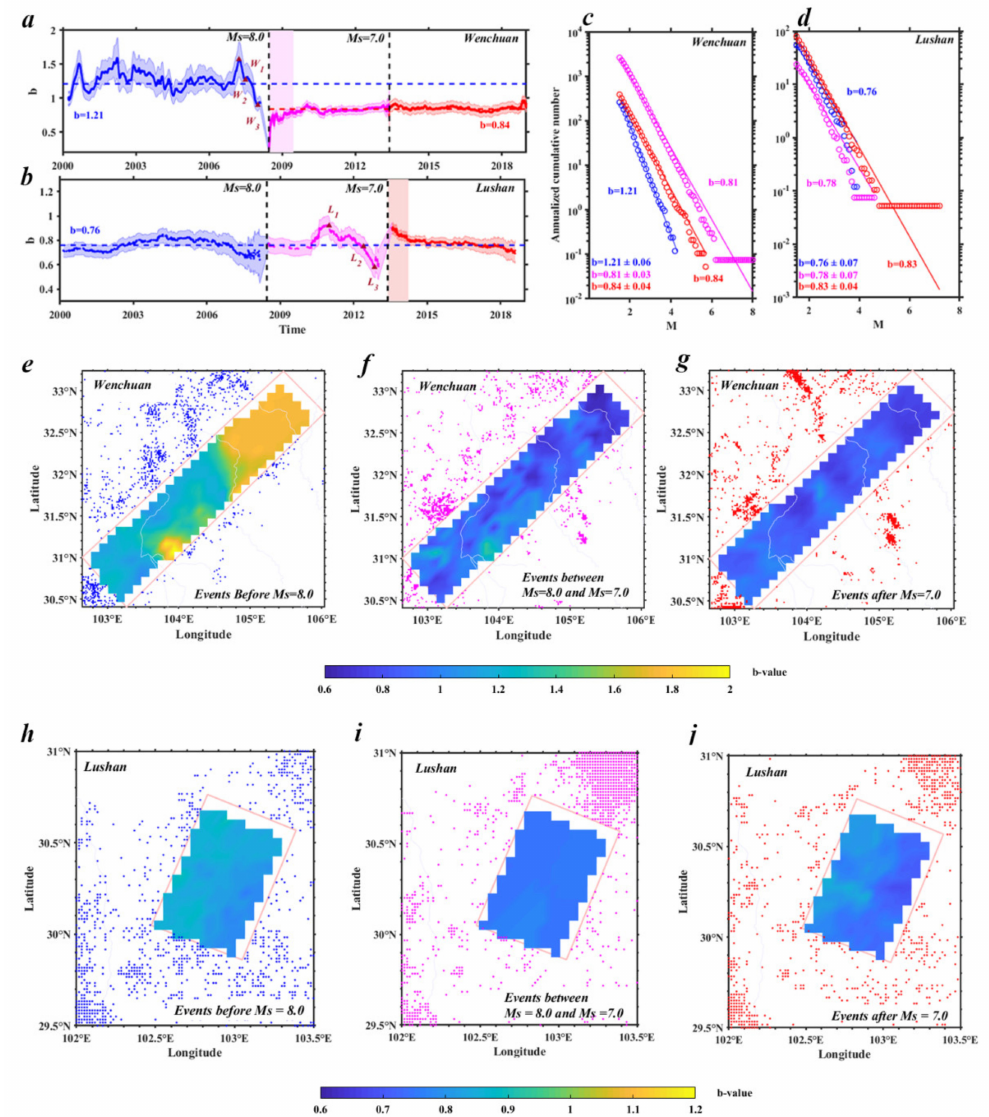
Figure 5. Temporal and spatial analysis of the b values for the Wenchuan-Lushan sequence. ( a , b ) Tem- poral variation of b values for the Wenchuan and Lushan source regions. The dashed black lines represent the times of the M S 8.0 (Wenchuan) and M S 7.0 (Lushan) events, and the dashed blue lines show the background b values for the Wenchuan and Lushan source regions. The dashed red line represents the b value after the time of the M S 7.0 event (Lushan) for the Wenchuan source region. The shaded regions represent the uncertainties in the b values. ( c , d ) FMDs for the two aftershock zones in three different periods. ( e – g ) Map showing the spatial footprint of b values for the Wenchuan aftershock zone in three different periods. ( h – j ) Map showing the spatial footprint of b values for the Lushan aftershock zone in three different